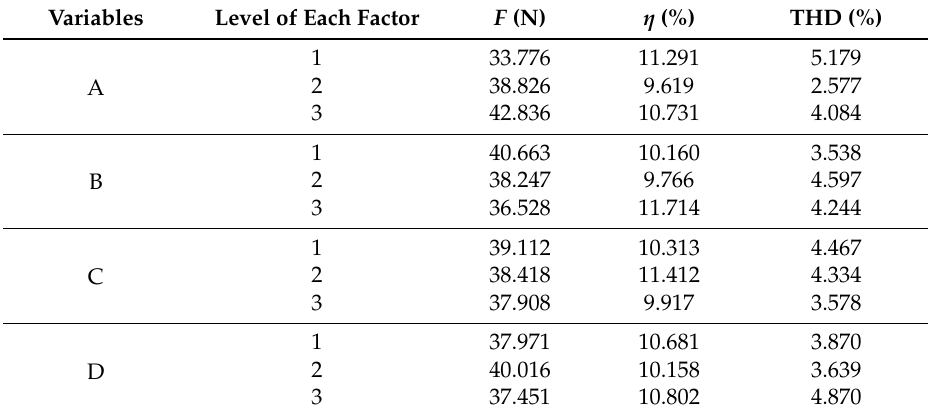
Table 5. Average values of performance under each level of factor variable index.